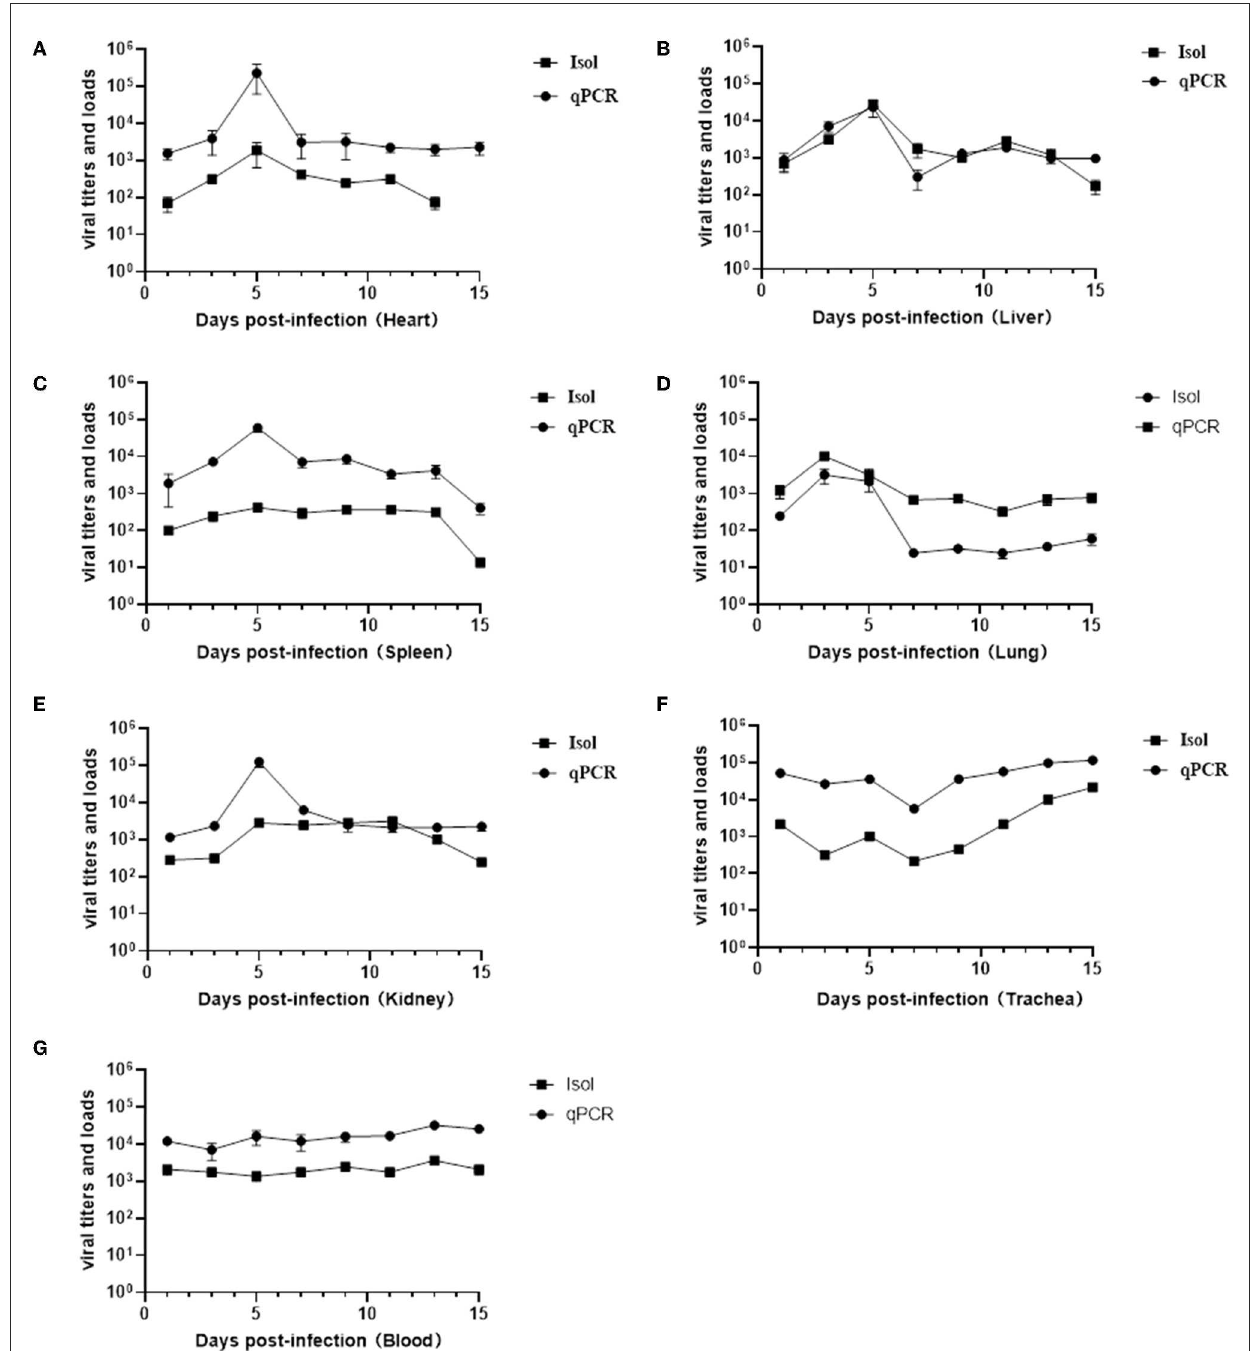
FIGURE6 Results of viral titers (TCID 50 ) and viral loads in various organs and blood at different infection time. Virus titration and viral load changes in the hearts (A) , livers (B) , spleens (C) , lungs (D) , kidneys (E) , trachea (F) , and blood (G) .